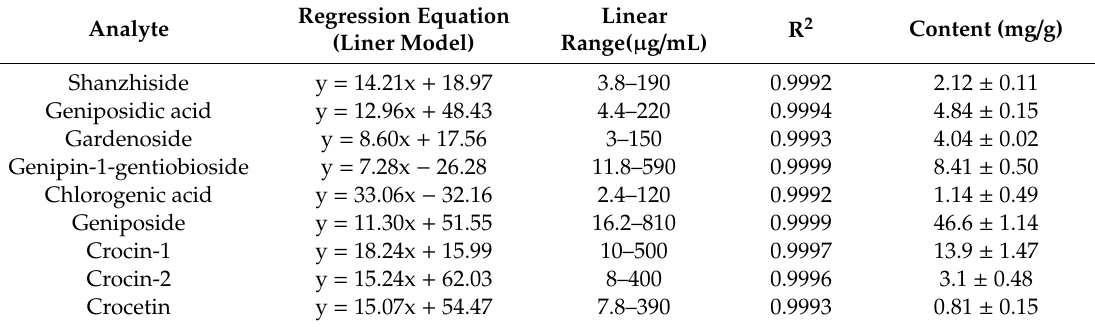
Table 2. Equation, determination coe ffi cient, linear range, and compounds content of nine compounds of Fructus Gardeniae